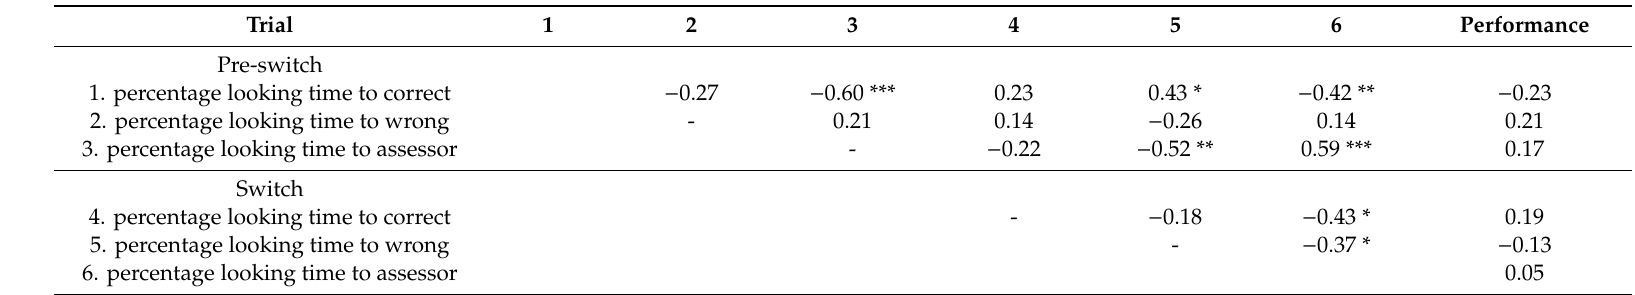
Table 2. Correlations (Kendall’s tau) between continuous looking behavior measures and the total number of switches correct performance measure (all